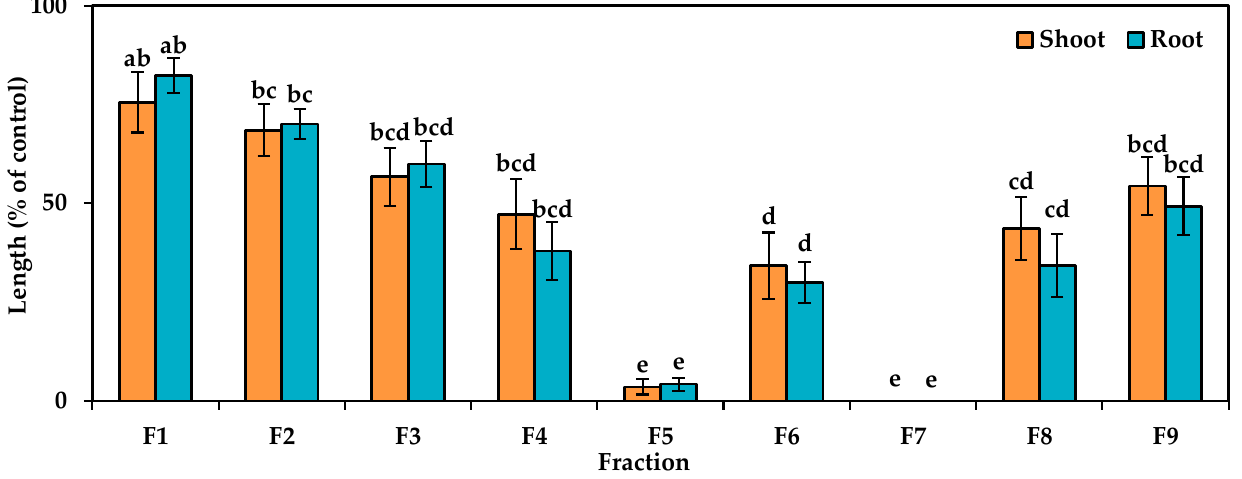
Figure 4. Allelopathic activity against cress growth of the different fractions of the A. procera extracts obtained from the column of silica gel. The tested species was treated with the concentration of 9.3750 mg/mL. The vertical bars on the treatments indicate mean ± SE with three replications ( n = 60). Significant variations between the control and different treatments are represented by different letters (according to Tukey’s HSD test at the 0.05 level of probability).